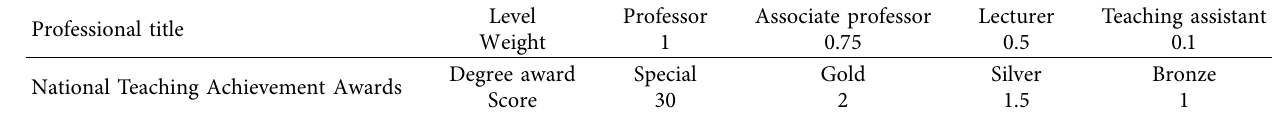
Table 1: Different scores for each item of different professional title and degree of award.